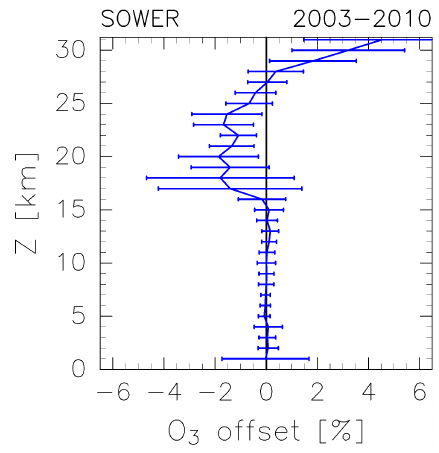
Figure 6. As for Fig. 4 but for ozone partial pressure and mixing